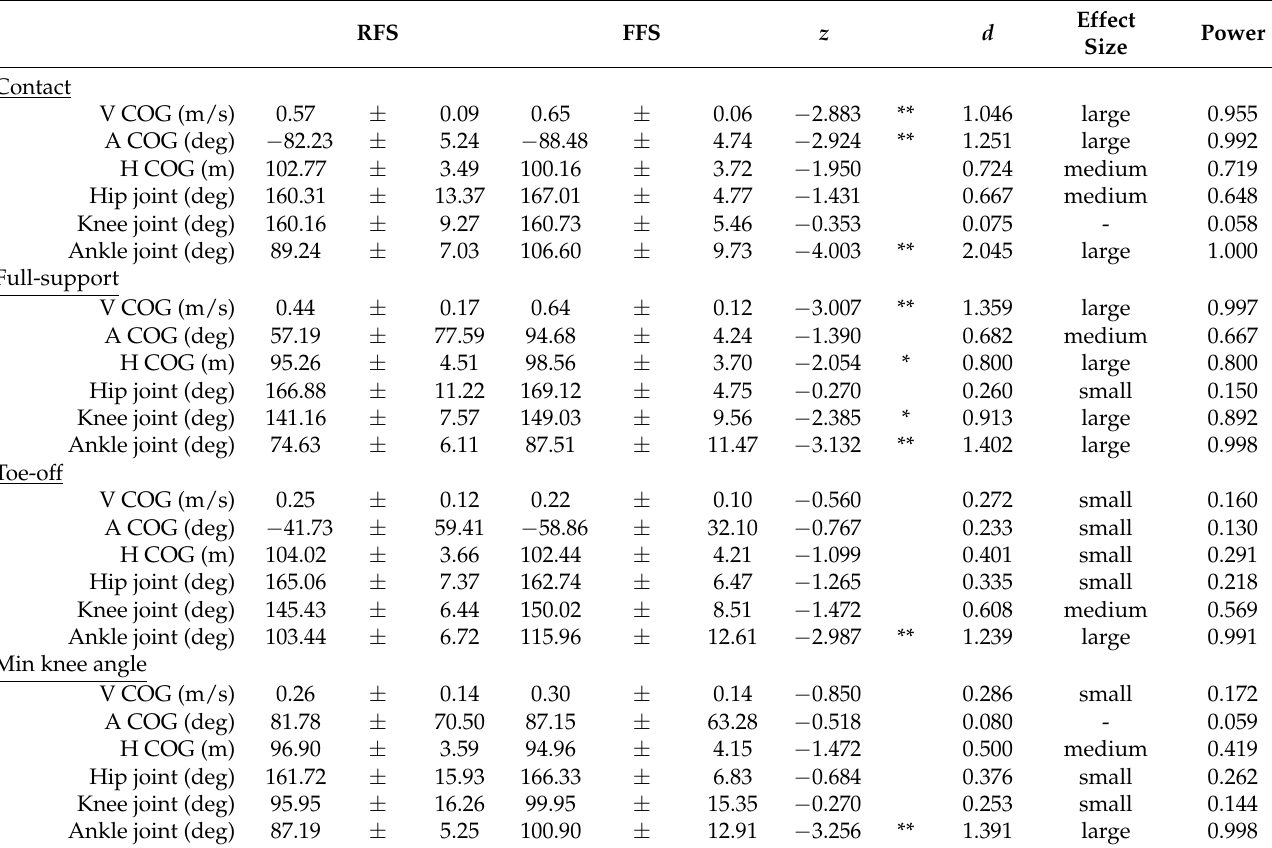
Table 3. Kinematics of various movements in male running period. (Mean ± SD) ( N = 15).